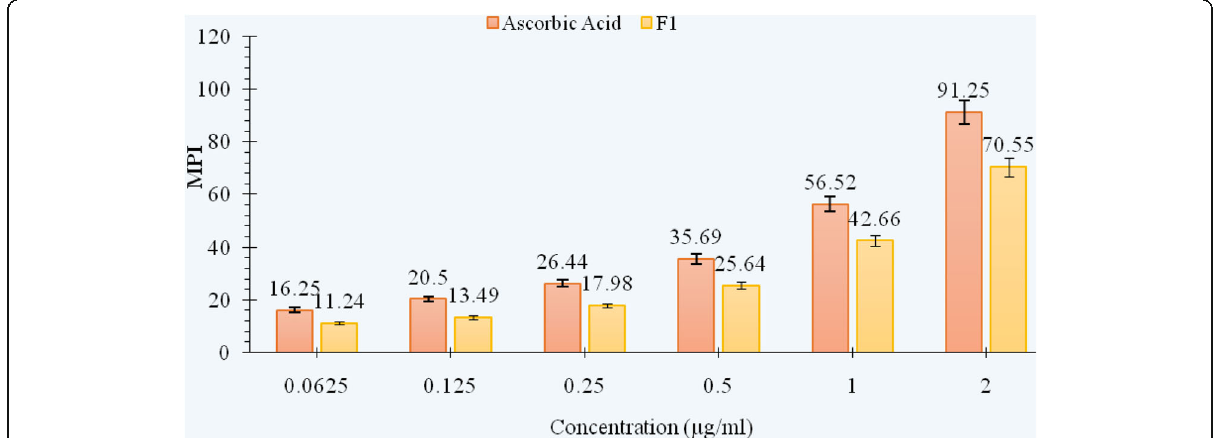
Fig. 5 Graph showing mean percentage inhibition of hydrogen peroxide by ascorbic acid and plant extract